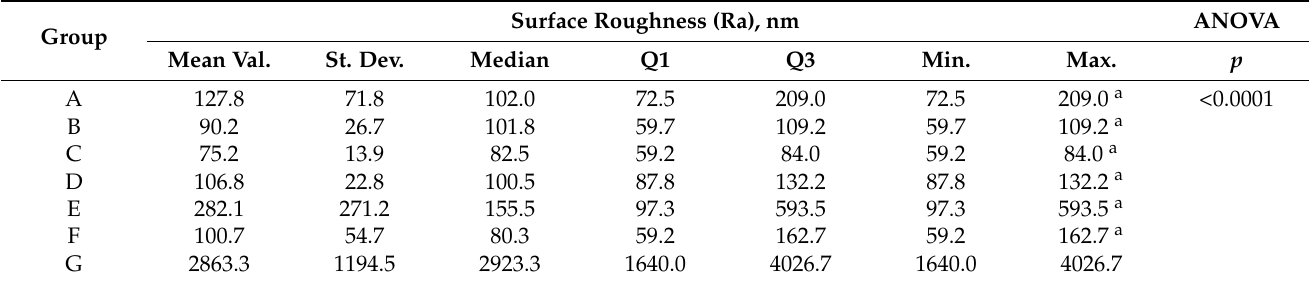
Table 4. Comparison of the roughness (Ra) between groups.